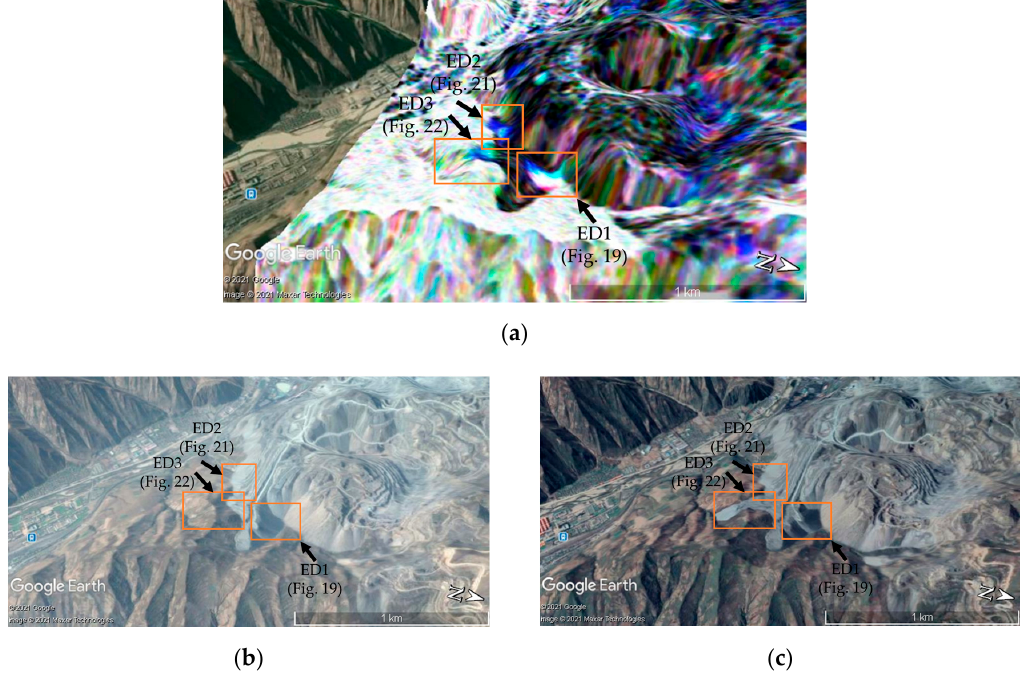
Figure 18. The east dumping area. ( a ) is the RGB composite of the annually averaged NDAI map (R: 2019, G: 2018, and B: 2017). ( b , c ) are Google Earth images taken on 7 October 2015 and 26 September 2019, respectively. Three active dumping sites named ED1, ED2, and ED3 are drawn in orange boxes, and the image viewing directions are indicated by arrows.